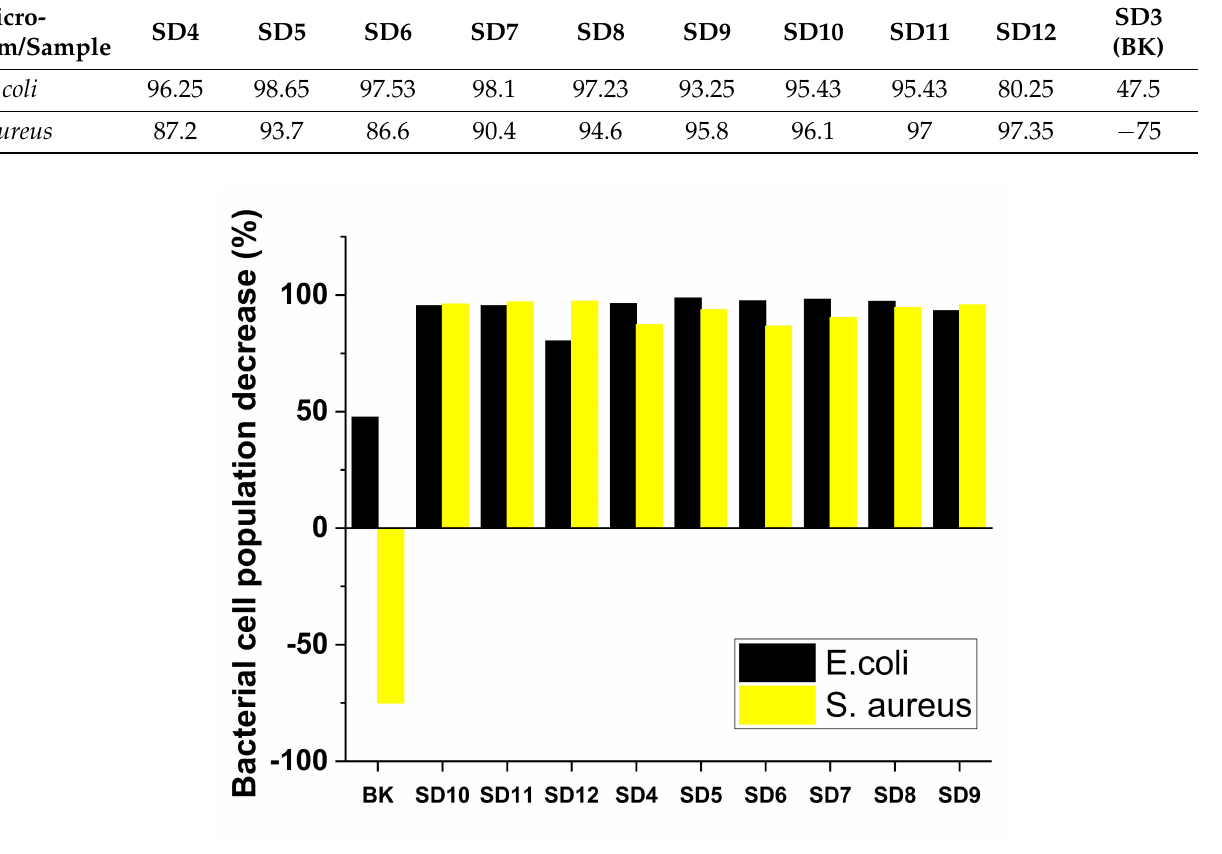
Figure 8. Bacterial cell population decrease (%) after 2 h of contact with decontamination